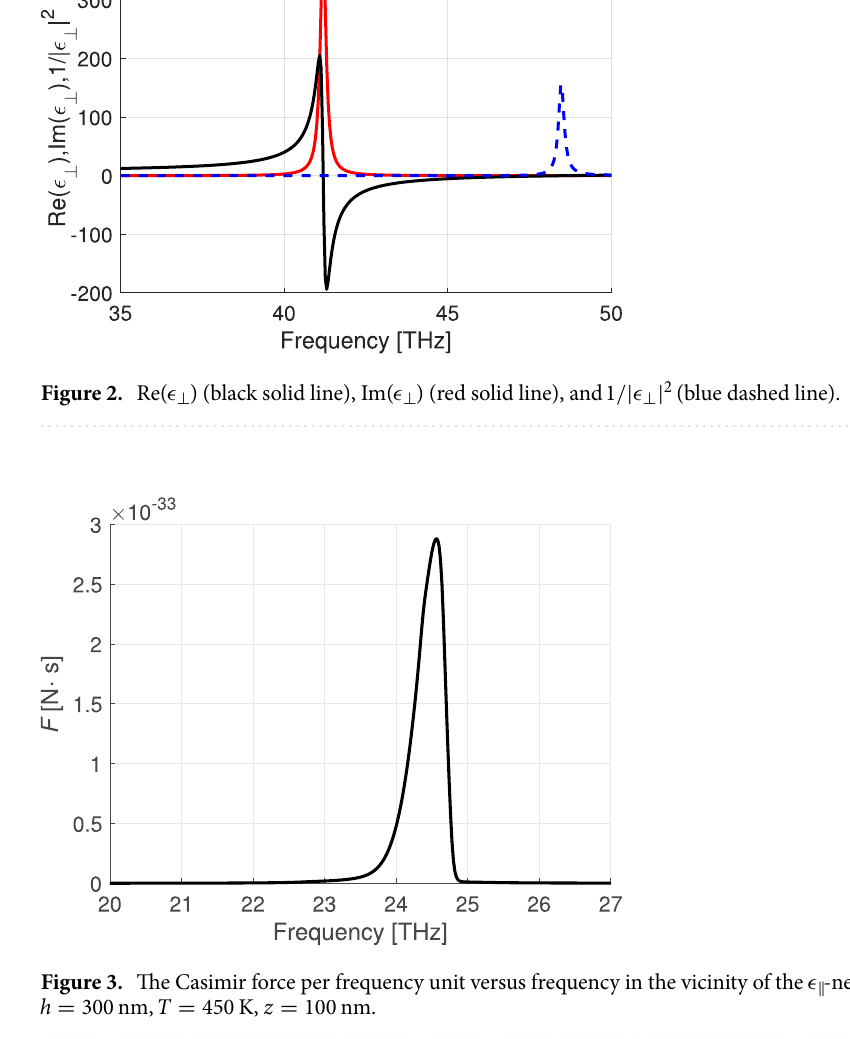
Figure 3. The Casimir force per frequency unit versus frequency in the vicinity of the ǫ 300 nm, T 450 K, z 100 h = = =